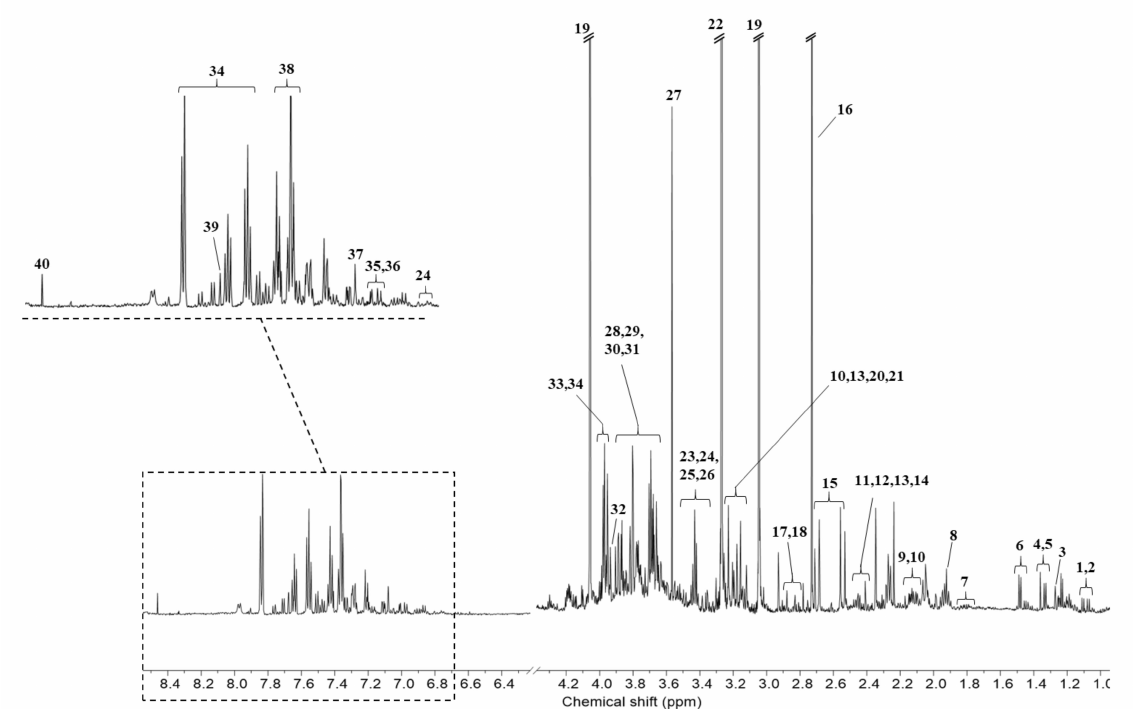
Figure 1. Representative 1 H NMR Spectrum with water suppression of urological cancer. (1) Valine, (2) 3-Hydroxyisobutyrate, (3) 3-Hydroxyisovalerate, (4) 2-Hydroxyisobutyrate, (5) Lactate, (6) Alanine, (7) Lysine, (8) Acetate, (9) Methionine, (10) O- Acetylcarnitine, (11) Pyroglutamate, (12) Succinate, (13) Carnitine, (14) Glutamine, (15) Citrate, (16) Dimethylamine, (17) N,N - Dimethylglycine, (18) N -Methylhydantoin, (19) Creatinine, (20) cis-Aconitate, (21) Choline, (22) Trimethylamine N-oxide, (23) Taurine, (24) 4-Hydroxyphenylacetate, (25) Glucose, (26) myo-Inositol, (27) Glycine, (28) Arabinitol, (29) Gluconate, (30) Mannitol, (31) Betaine, (32) Creatine, (33) Glycolate, (34) Hippurate, (35) Tyrosine, (36) 4-Hydroxybenzoate, (37) Histidine, (38) N-Phenylacetylglycine, (39) Pseudouridine, (40) Formate. The region of water and urea was